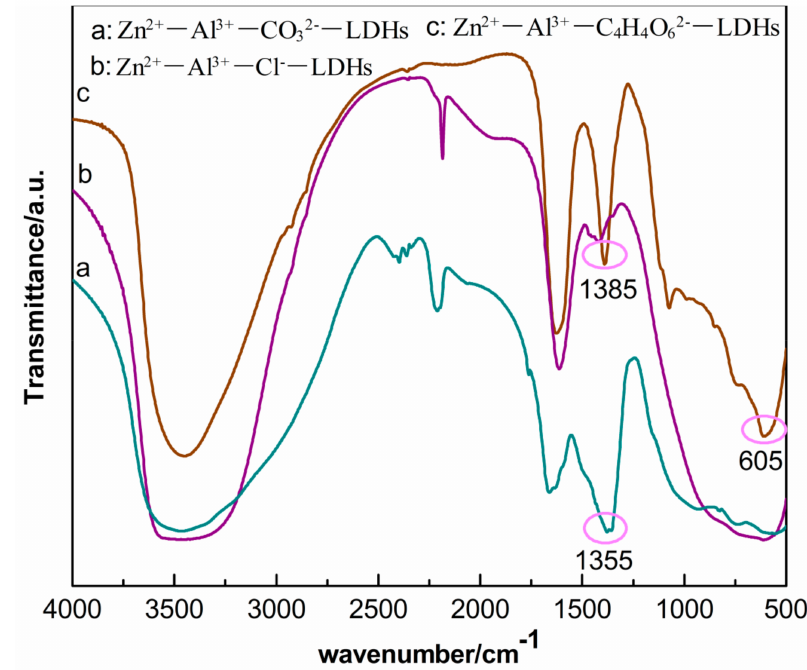
Figure 3. FT-IR spectra of LDHs